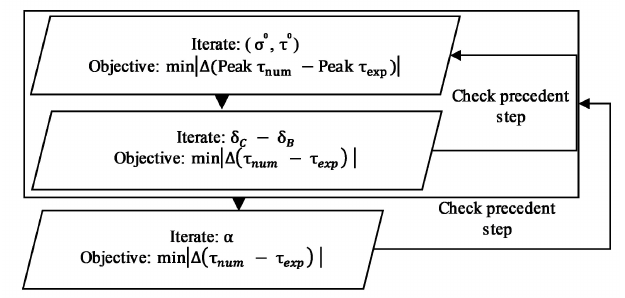
Figure 20. Calibration of the model.